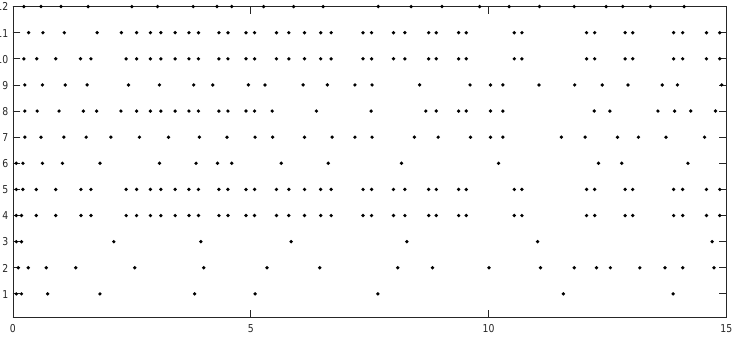
Figure 3. Event instants on edges 1–12 ( τ = 0, 15